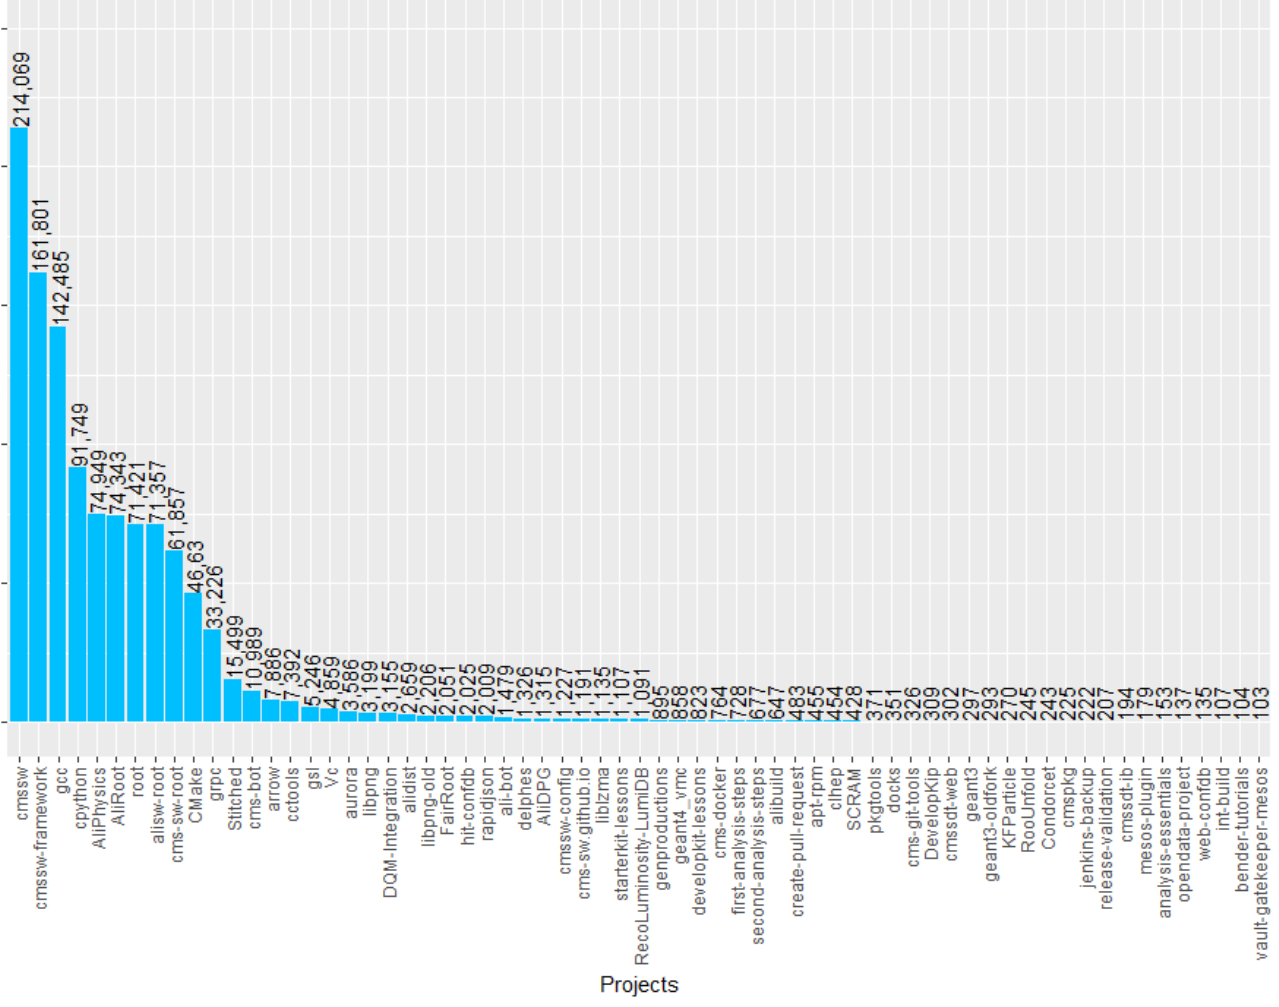
Figure 3. Number of commits per